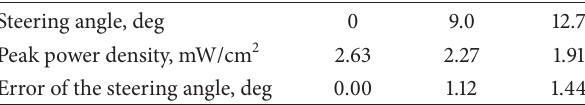
Table 1: Axial ratios for respective SRAs.